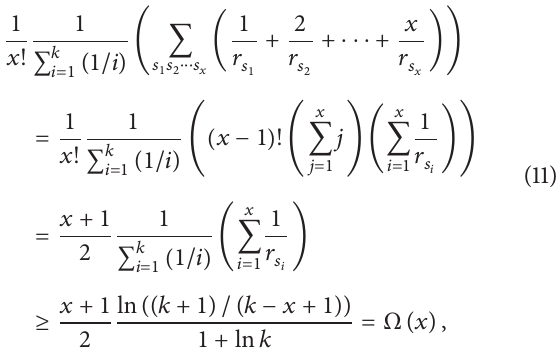
Figure 5: Example of choice in server